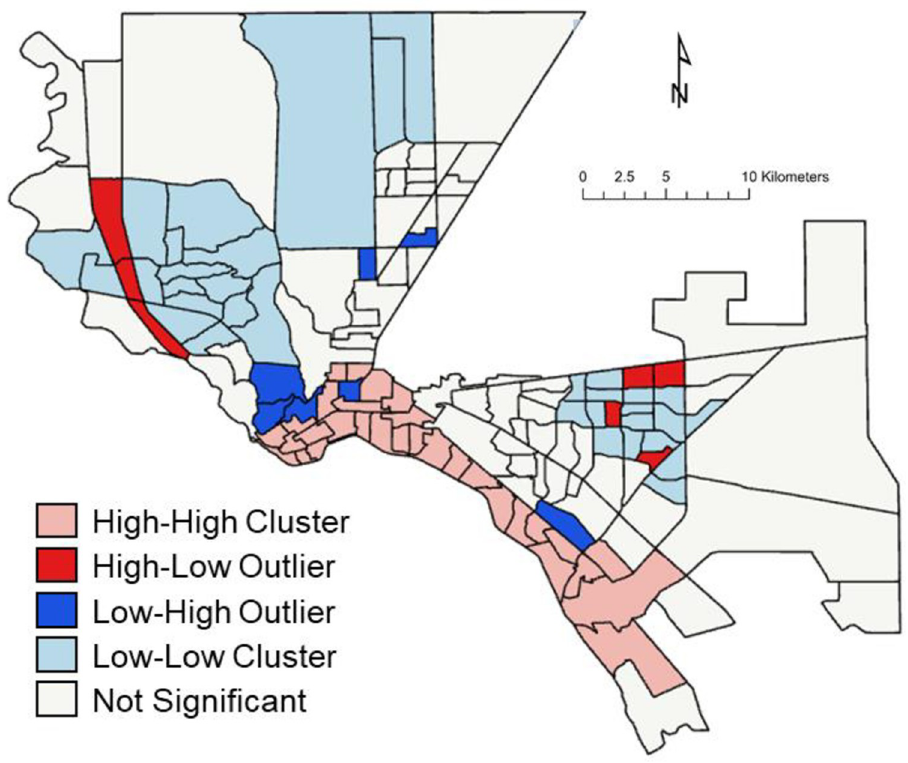
Fig 7. Statistically-significant (95% confidence level) clusters and outliers for fractions of households in census tracts with fractions of income spent on municipal water of � 5%,for the Climate Change + Imported GW + HB Depletion scenario in 2070. High-High Cluster and Low-Low Cluster refer to clusters of census tracts with high or levels of fractions of households, respectively. High-Low Outlier and Low-High Outlier refer to census tracts with high or low levels of fractions of households located in clusters of low or high levels of fractions of households, respectively. Not Significant refers to census tracts that are neither part of a statistically significant cluster nor a statistically significant outlier, relative to the 95% confidence level. Basemap (census tract boundaries): TIGER Geodatabase, US Census. Data representation: Work of the